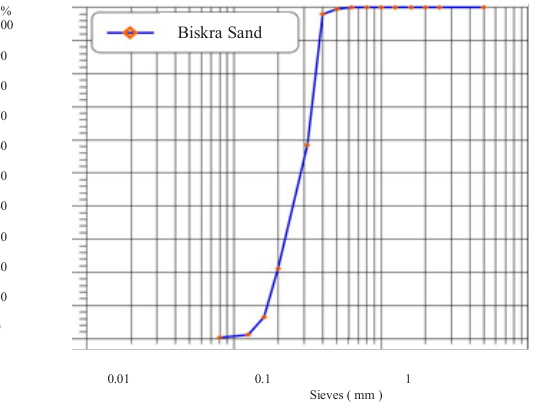
Figure 2: Granulometric analysis of Biskra Sand Dune (cumulative). Table 1: Granulometric proprieties of Biskra Silica